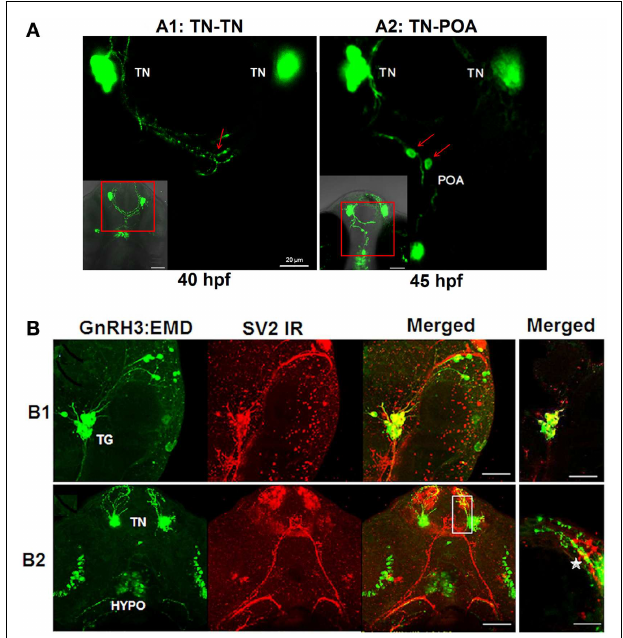
FIGURE 5 | Formation of GnRH3 neuronal circuits during embryogenesis . (A) Representative confocal images (ventral view) showing close apposition of neural processes between GnRH3 populations. (A1) Example of connectivity between GnRH3 neuronal processes between two populations of the terminal nerve clusters (TN-TN). (A2) Example of connectivity between GnRH3 neuronal processes between terminal nerve and preoptic area populations (TN-POA).The insets in the left corners show z -stack projections of the confocal images; the larger panels show a single optical slice (0.5m µ m) from the inset image data. Arrows point to region of close apposition between neuron groups. Left: close apposition between neural processes from the bilateral TN-GnRH3 neuron clusters at 40 hpf. Right: close apposition between the neural process from aTN-GnRH3 neuron and the soma of a POA GnRH3 neuron at 45 hpf. Scale bar: insets, 50 µ m; large panels, 20 µ m. (B) Whole mount immunohistochemistry staining of synaptic vesicle protein 2 (SV2; red fluorescence) and GFP fluorescent imaging of GnRH3:EMD. (B1) Representative confocal image (lateral view) of trigeminal GnRH3:EMD neurons with SV2 staining at 25 hpf. Far left: trigeminal neurons expressing GnRH3:EMD; middle left: SV2 positive staining; middle right: merged image of GnRH3:EMD and SV2 fluorescence; far right: merged image from a single optical plane (0.5 µ m). (B2) Representative confocal image (ventral view) of forebrain GnRH3:EMD neurons with SV2 staining at 50 hpf. Far left: GnRH3:EMD expression in terminal nerve (TN) and hypothalamus (HYPO); middle left: SV2 positive staining; middle right: merged image of GnRH3:EMD and SV2 fluorescence; far right: merged image from a single optical plane (0.5 µ m) shown in the white box in the adjacent panel, and enlarged.The star shows an area of co-localization of GnRH3:EMD and SV2 in a neural process. In (B1,B2) yellow indicates regions of co-localization between GnRH3:EMD and SV2. Scale bar: 50 µ m, except (B1) far right panel (20 µ m).